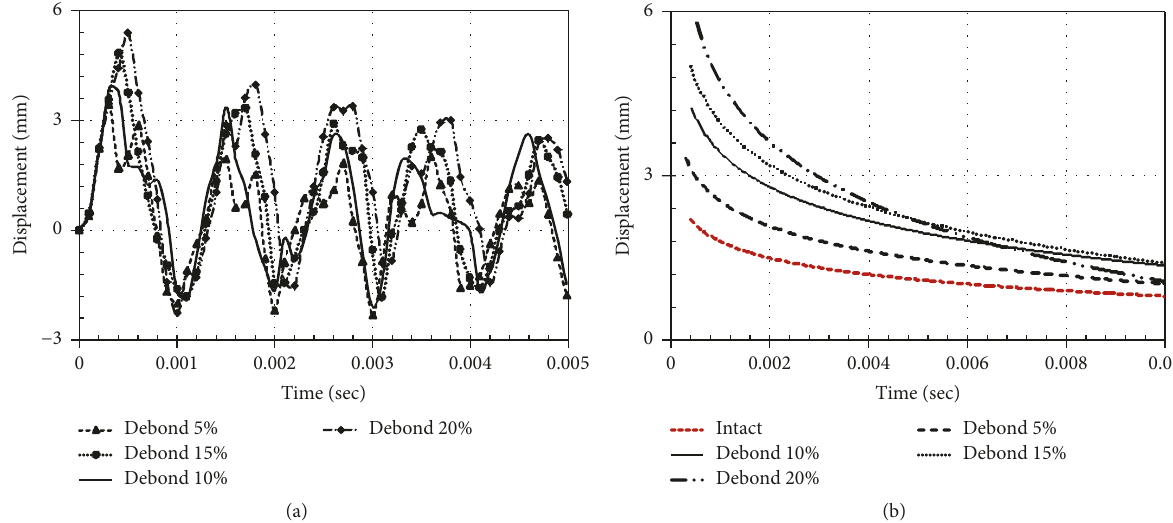
Figure 20: Transient response for different sizes of debonding at the central plate point [75]: (a) displacement curves and (b) displacement curves